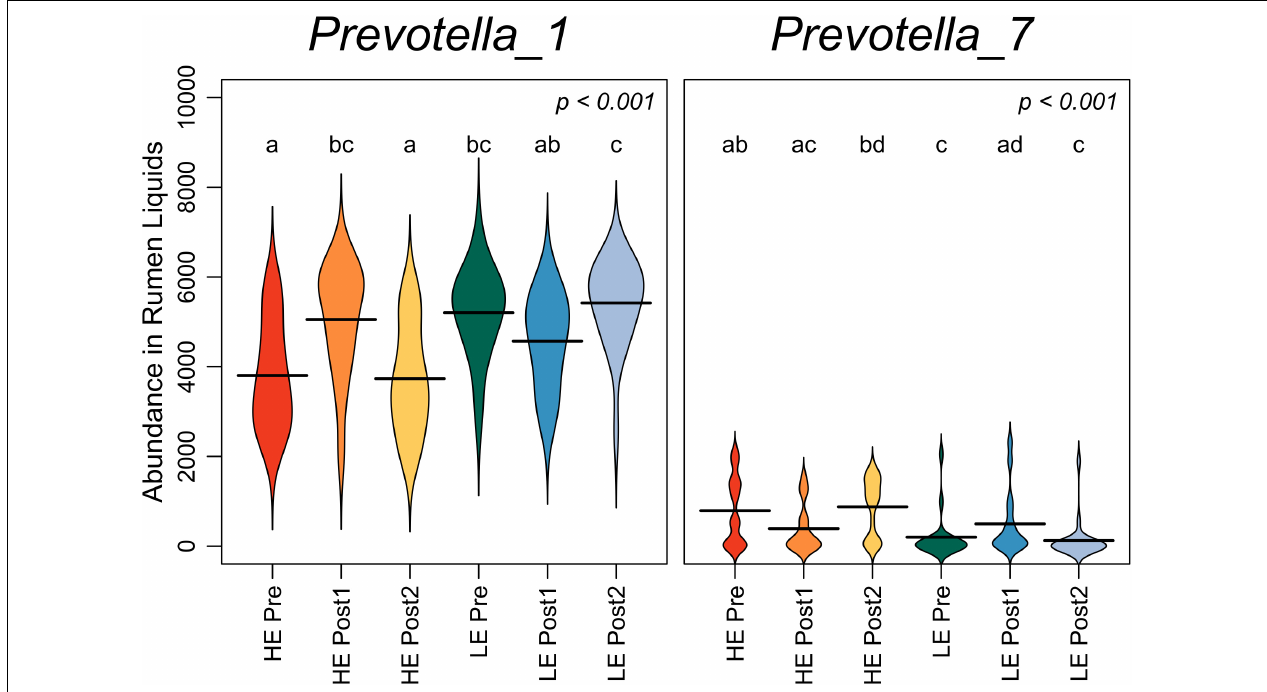
FIGURE 3 | Beanplots expressing abundance of normalized bacterial reads classifying to genera Prevotella_1 and Prevotella_7 in liquid-derived rumen samples by time within the study and initial host efficiency. Shared letters indicate no difference in read abundance ( p > 0.05).